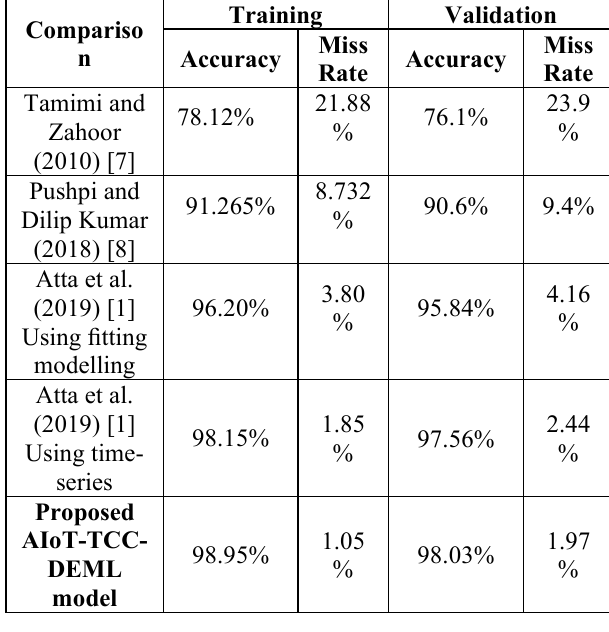
Tab. 3 indicates the accuracy of the proposed TC2S- DNN model during testing and validation. Accuracy and error rates are estimated to be 98.95 percent and 1.05 percent respectively. The accuracy and error rate